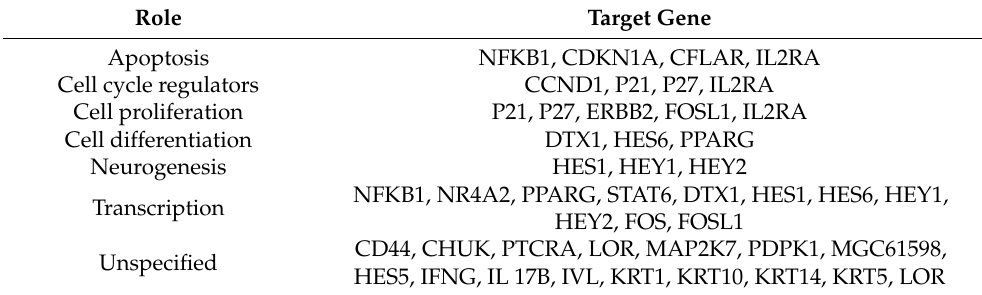
Table 1. Notch signaling pathways target